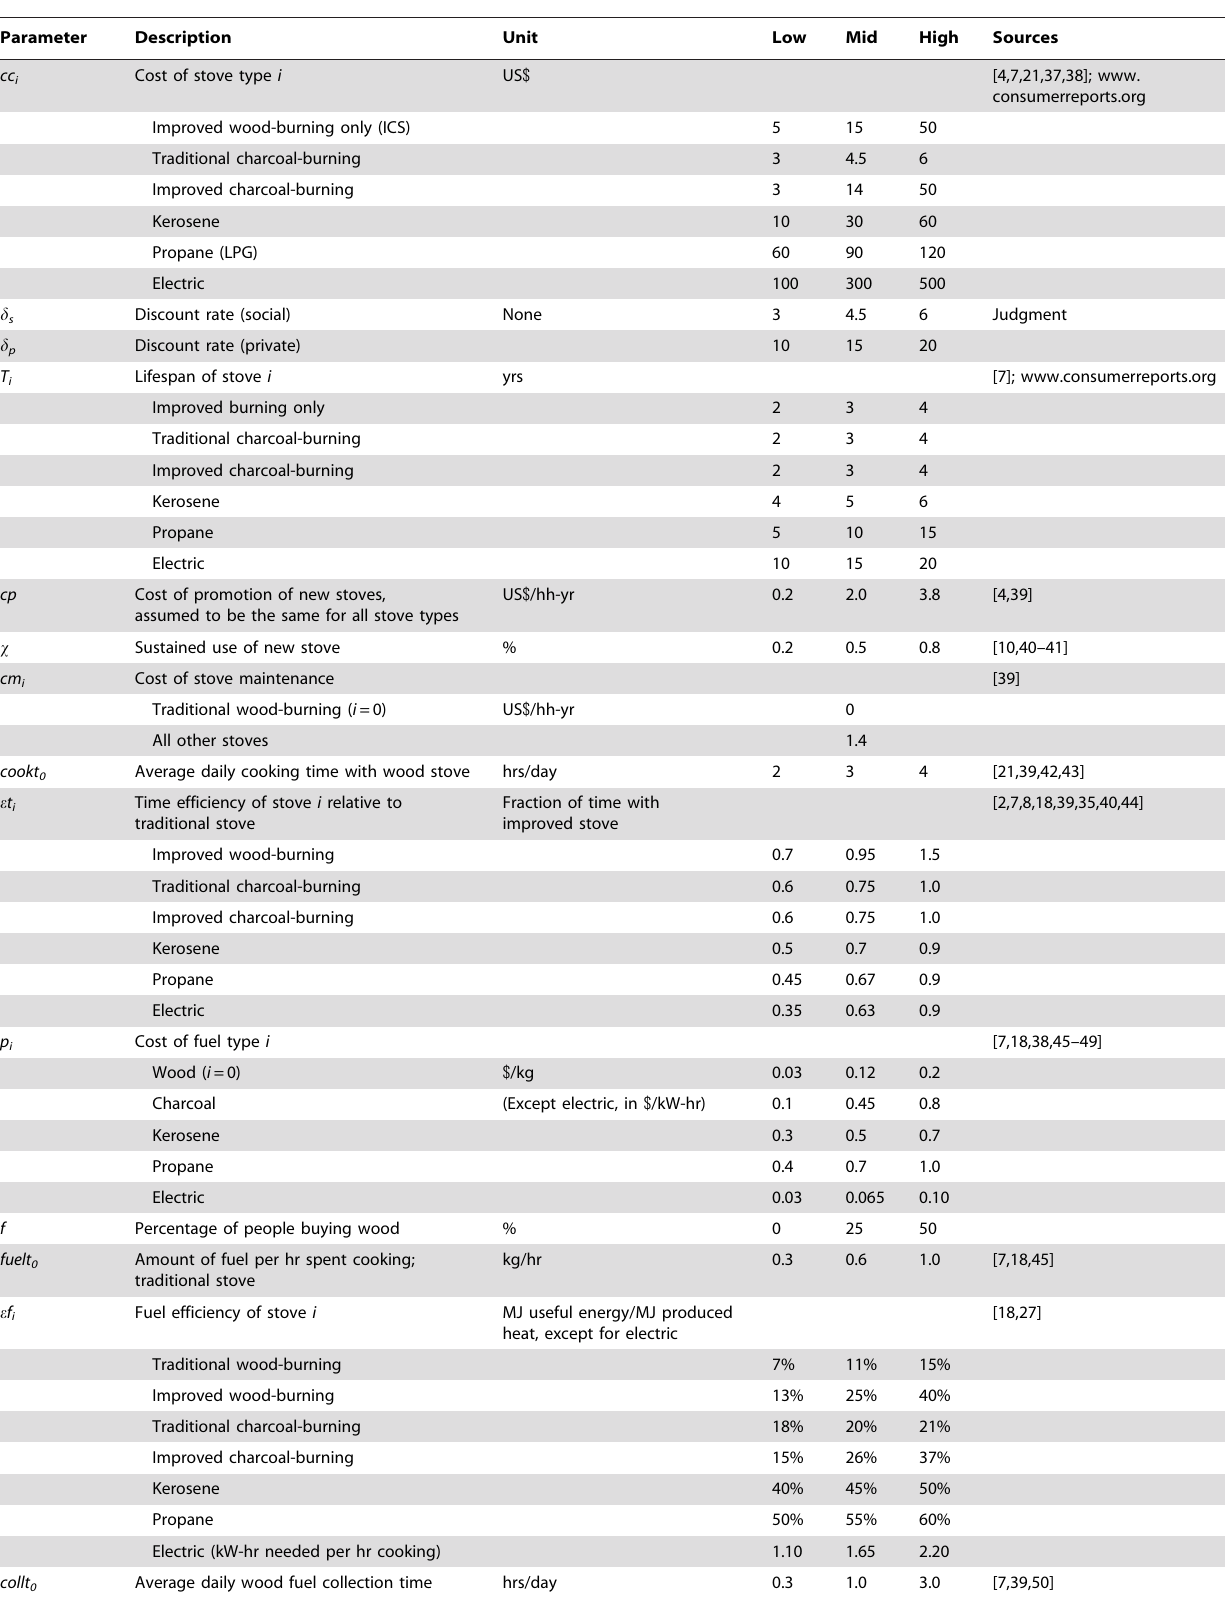
Table 2. Definition of model parameters for analysis of costs and benefits of cook stove technologies.